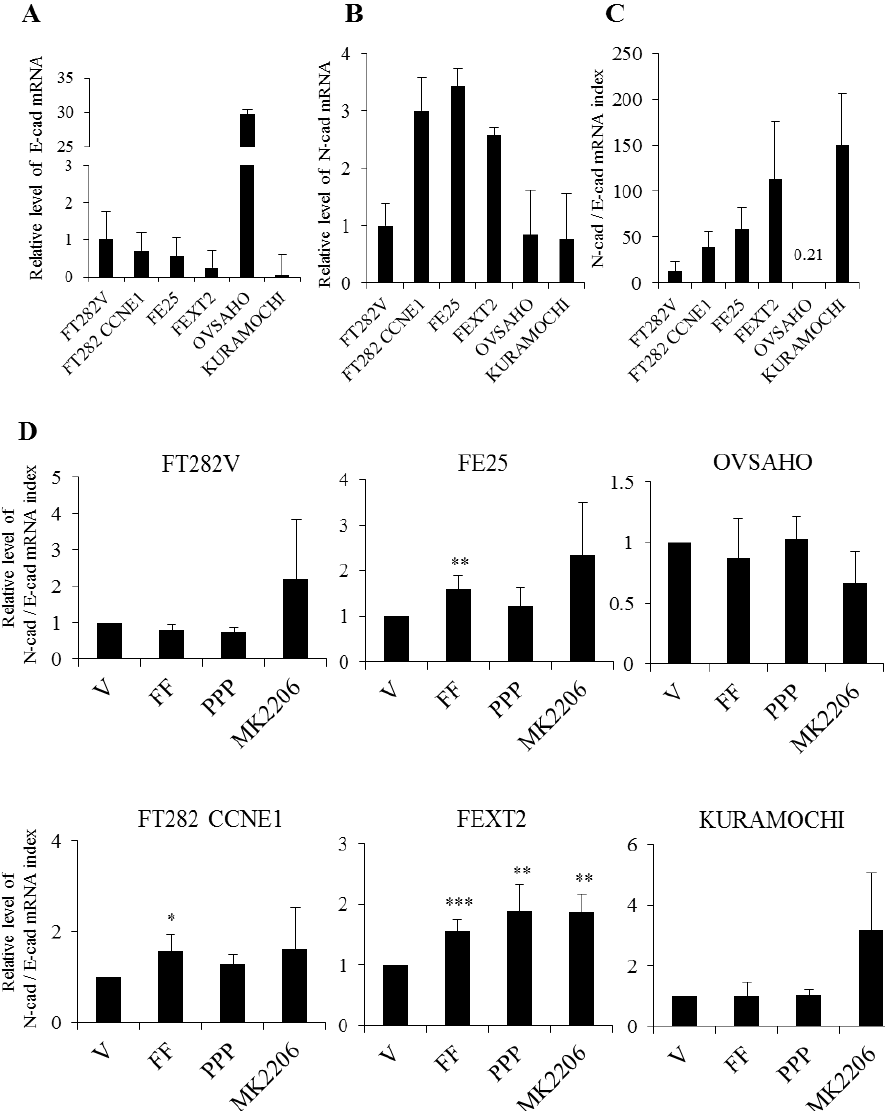
Figure 8. EMT assay of transforming FTE /HGSC cells. ( A – C ) mRNA levels of E-Cadherin and N-cadherin of each cell line were analyzed using real-time PCR. Baseline levels were shown with FT282-V as a reference. ( D ) EMT level, represented by N-cadherin/E-cadherin value, was compared in different cells with the same FF or vehicle treatment with or without IGF-1R or AKT inhibition. Mean ± SD from three or over three independent experiments. * p < 0.05, ** p < 0.01, *** p < 0.001 by two-sided, unpaired Student’s t -test.